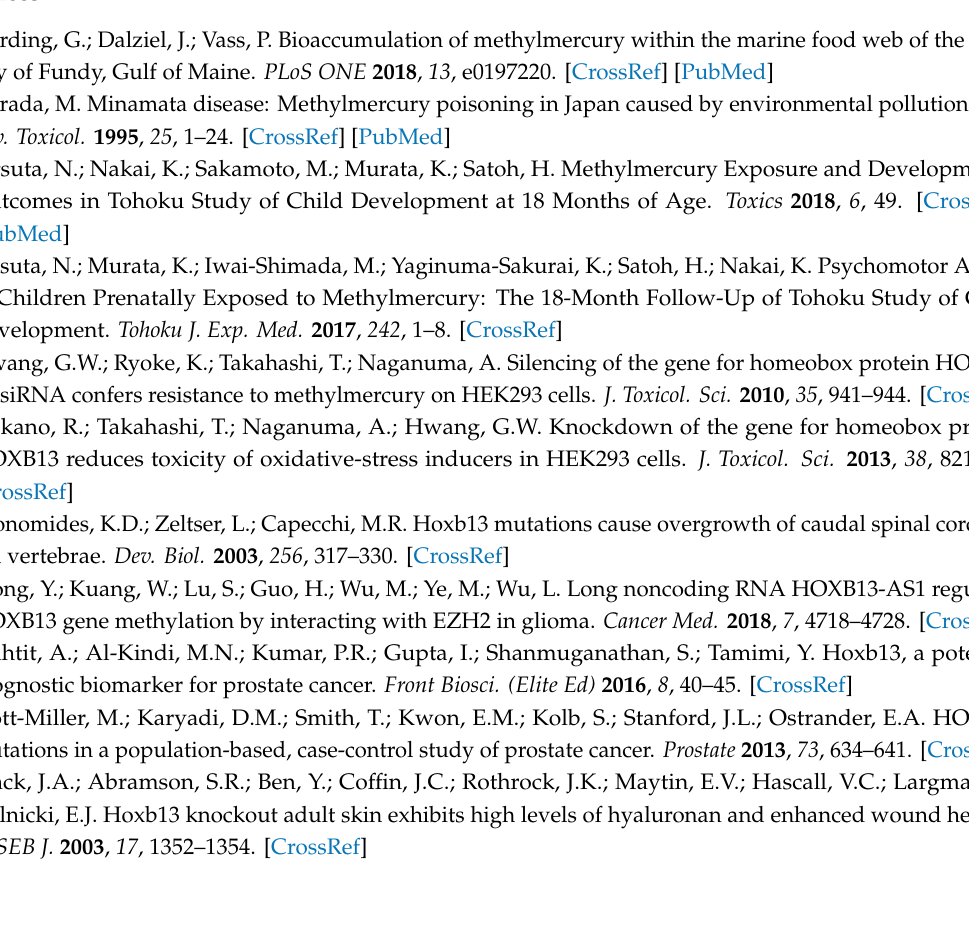
Figure S1: Sequence of primers for quantitative PCR and siRNAs, Figure S2: E ff ects of knockdown of RFPL4A or OSM on cytotoxicity caused by methylmercury, Figure S3: E ff ects of knockdown of HOXB13 on methylmercury induced OSM expression, Figure S4: Validation of immuno-fluorescence (IF) of HOXB13 in HEK923 cells, Figure S5: E ff ects of knockdown of TNF receptors on cytotoxicity caused by methylmercury, Figure S6: E ff ects of neutralizing antibody against OSM on methylmercury induced cell death in C17.2